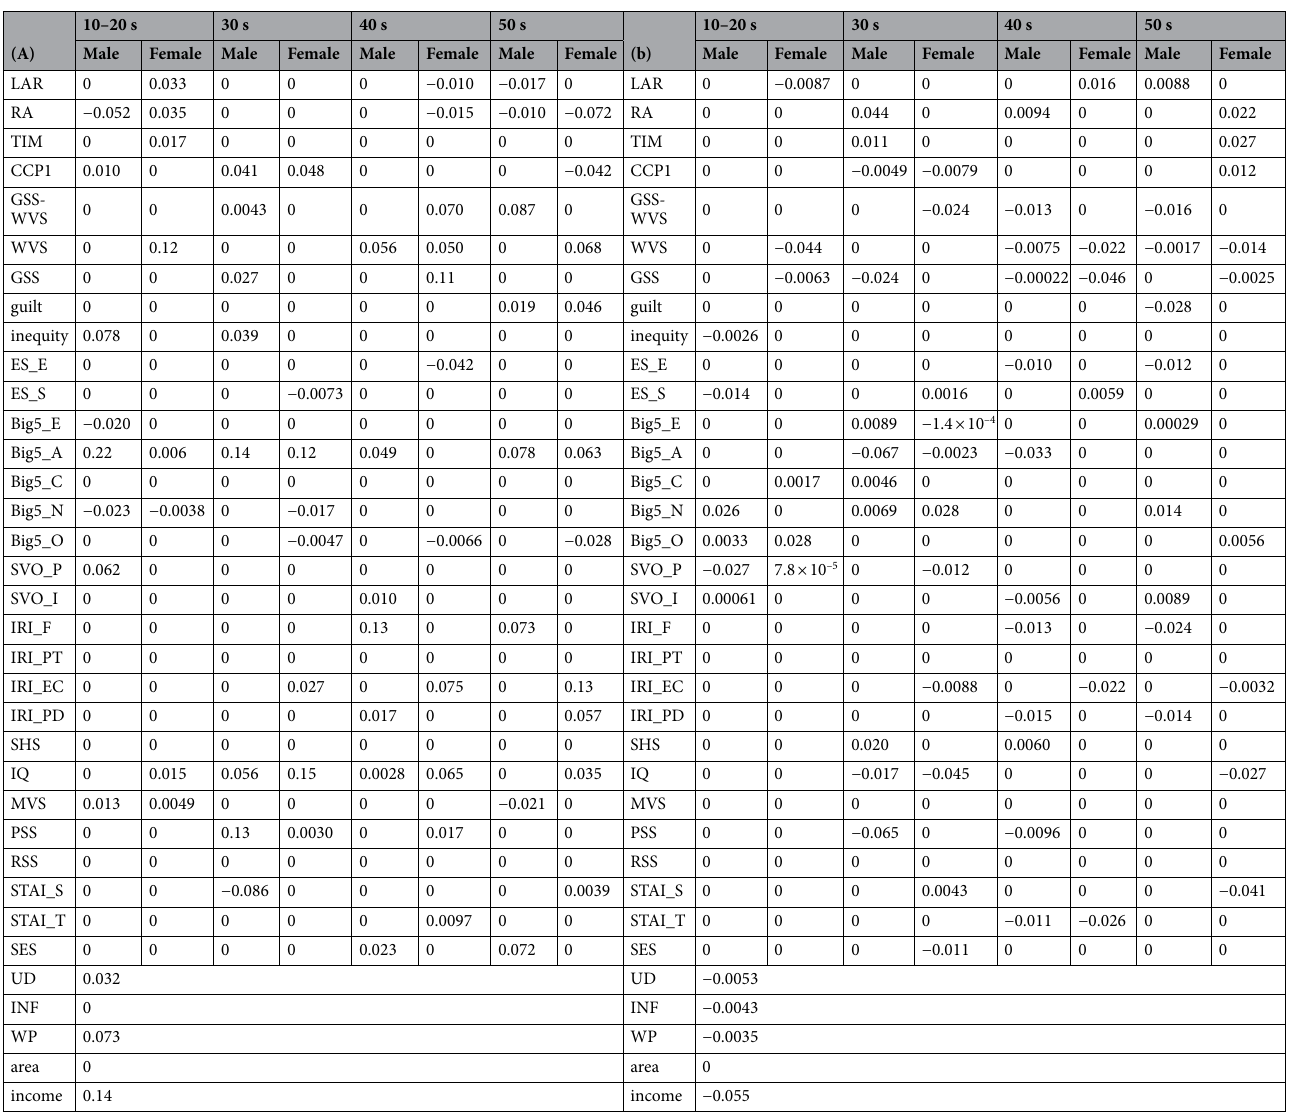
Table 3. LASSO regression of the willingness and refusal to be vaccinated by social personality trait scores and demographic characteristics (and their interactions). UD, underlying disease; INF, infected close relative; WP, workplace; area, place of residence; income, annual